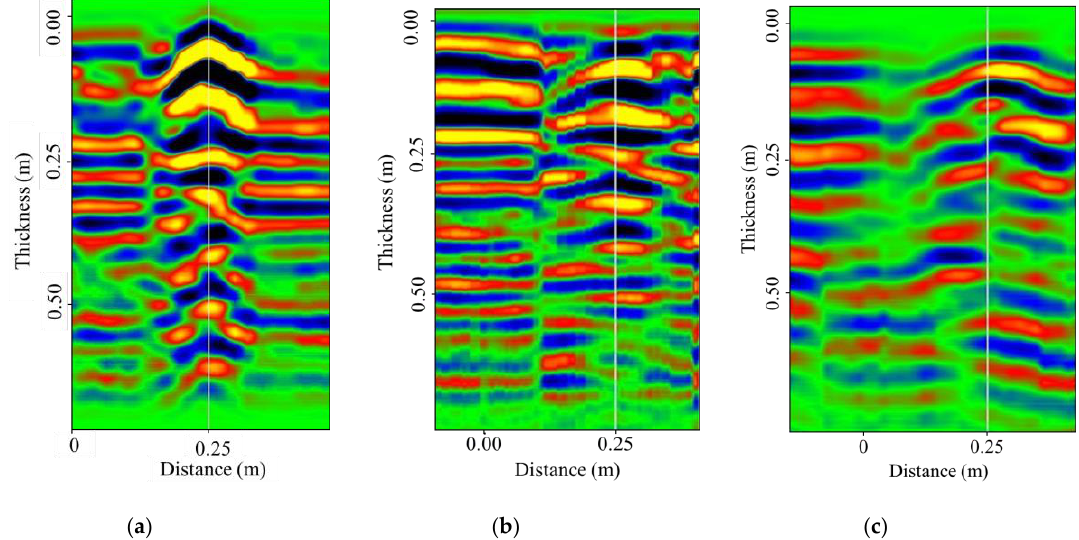
Figure 8. The different patterns of grouting holes obtained from GPR detection results: ( a ) empty; ( b ) filled with water; ( c ) filled with grout.